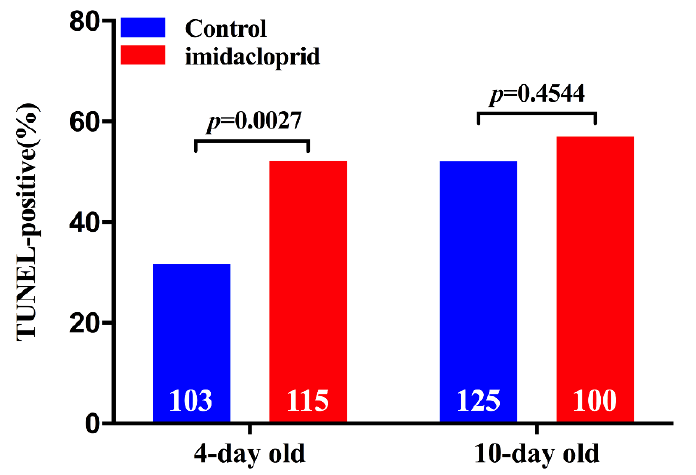
Figure 3. TUNEL quantification. TUNEL-positive tropharia were recorded and presented as a percentage of the examined tropharia both in the control and treatment group of ovaries from viruliferous female SBPH at 4 and 10 days after emergence. The data were analyzed by Chi-square ( χ 2 ) test. White numbers within bars at the bottom show the total number of examined tropharia.